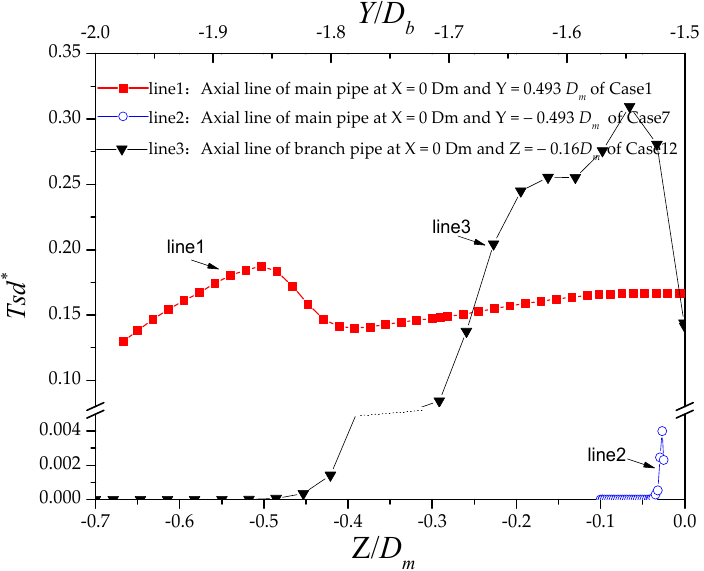
Figure 13. Axial distribution of temperature fluctuation intensity along corresponding lines.